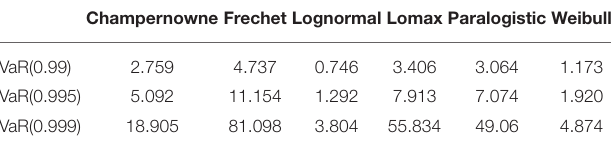
TABLE 16 | External Fraud Risk: Information criteria for truncated Champernowne, Frechet, Lognormal, Lomax, Paralogistic, and Weibull models. Champernowne Frechet Lognormal Lomax Paralogistic Weibull